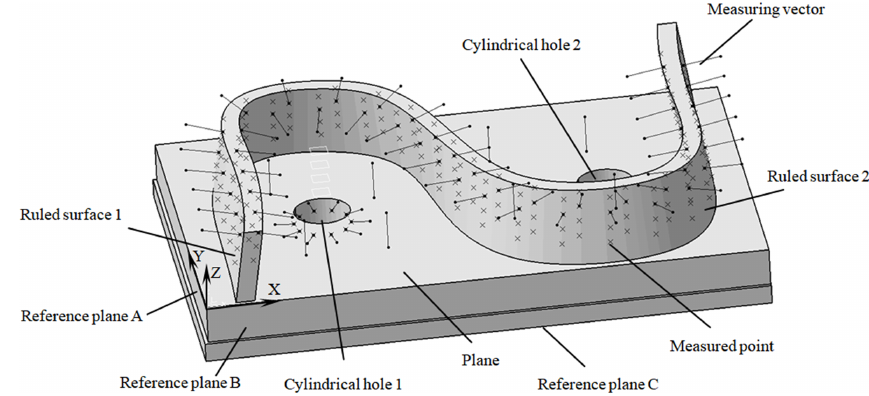
Figure 4. The model of S-shaped workpiece.